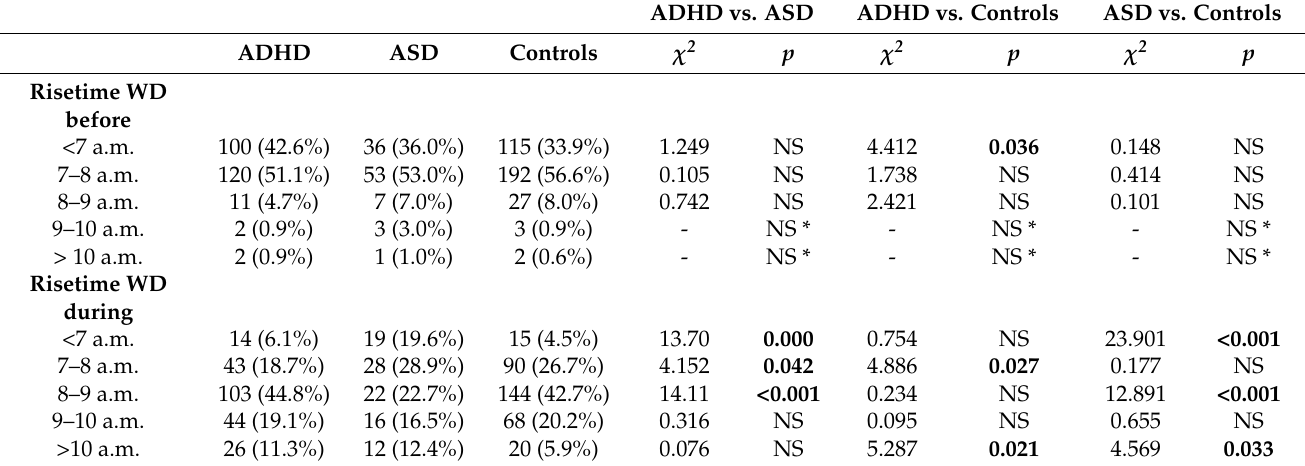
Table 3. Comparison between risetime in weekdays before and during lockdown in the three groups. ADHD vs. ASD ADHD vs. Controls ASD vs. Controls